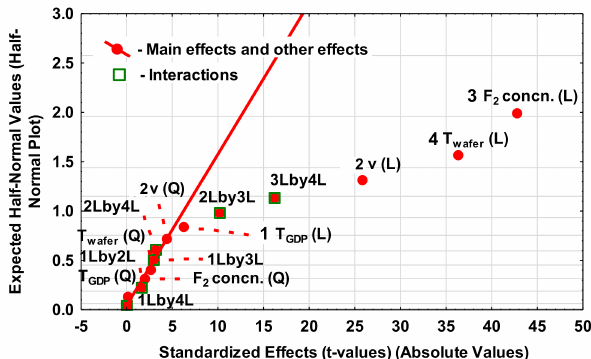
Figure 4. Half-normal plots to identify the significant factors to influence the etch rate. The straight lines in ii) are linear fits of the main e ff ects (red filled circles ) and interaction e ff ects (green empty squares) that have an absolute value lower than 5. Here, 1, 2, 3, and 4 represent the process parameters T GDP , v , ff ect (linear or quadratic) that the individual σ F , and T wafer respectively. L and Q represent the type of e process parameters or their mutual interactions have on the dependent variable (here, etch rate). The mutual interaction e ff ects between two parameters, for instance 1 and 2, are represented here as 1L by 2L and 1Q by 2Q for linear and quadratic interactions